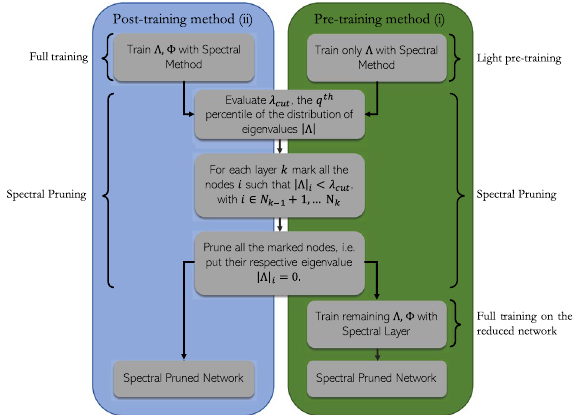
Figure 5. Flowchart of the pre- and post- speactral training pruning strategies as presented in “